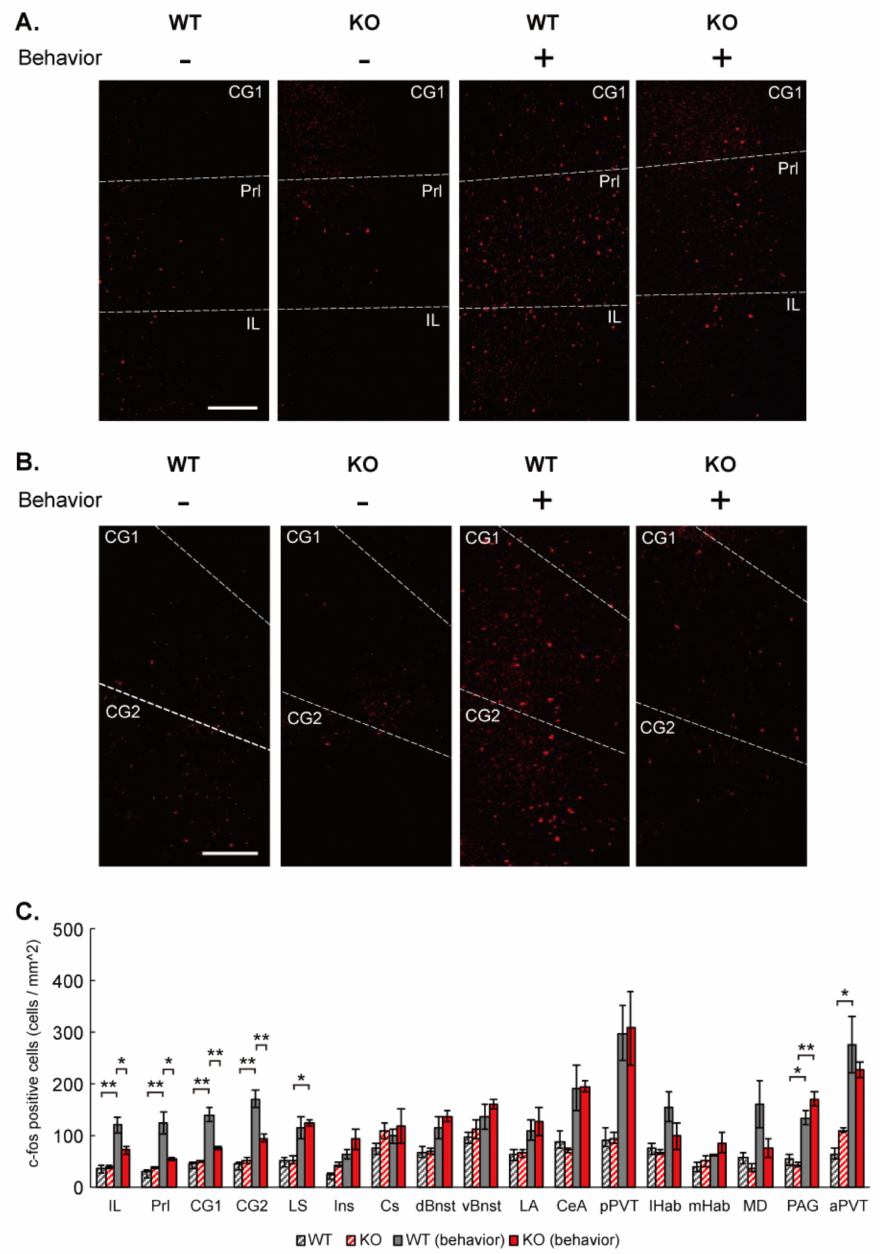
Figure 2. Elevated c-Fos expression in the mPFC by social stimulation is diminished in IQSEC2 KO mice. ( A , B ) Representative images for c-Fos immunostaining in the brain slices containing mPFC Figure 2. KO (KO) mice with and without imposing social behavior. Scale bar = 0.2 mm. ( C ) Summary graph for c-Fos expression in wild-type (WT) and IQSEC2 KO (KO) mice with and without imposing social behavior in different brain regions. The number of c-Fos positive neuron/mm 2 is shown in the bar graph. c-Fos expression is up-regulated in IL, Prl, CG1, CG2, LS, PAG, aPVT in wild-type mice after social behavior. The up-regulation is diminished in IL, Prl, CG1, CG2. Abbreviations; IL: infralimbic cortex, Prl: prelimbic cortex, CG1: cingulate area 1, CG2: cingulate area 2, LS: lateral septum, Ins: insula, Cs: cingulate sulcus, dBnst: dorsal bed nucleus of the stria terminalis, vBnst: ventral bed nucleus of the stria terminalis, LA: lateral amygdala, CeA: central amygdala, pPVT: posterior paraventricular thalamus, lHaB: lateral habenula, mHaB: medial habenula, MD: medial dorsal thalamus, PAG: periaqueductal gray, aPVT: anterior paraventricular thalamus. Data in the graph are means ± SEM. Statistical analyses were performed by One-way ANOVA followed by Tukey’s post-hoc test (* p < 0.05; ** p < 0.01. Data values used in graphs are shown in Table